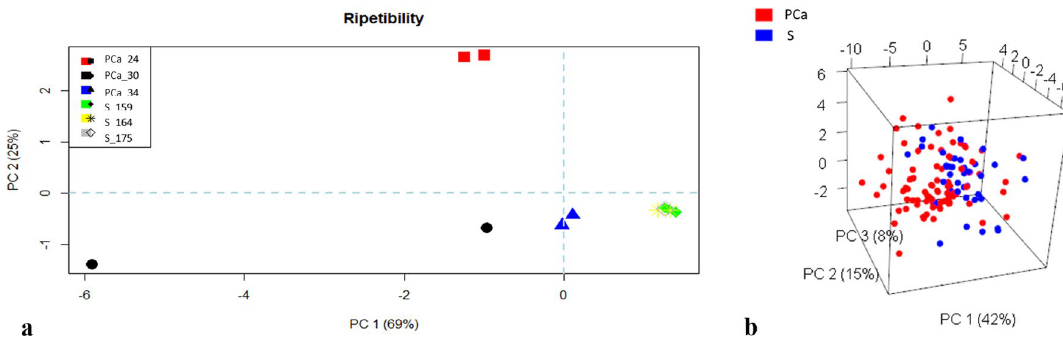
Figure 3. ( a ) Repeatability of e-nose responses relevant to urine samples from the same subjects; ( b ) PCA score plot relevant to the PCa diagnosis model ( S control, PCa prostate cancer